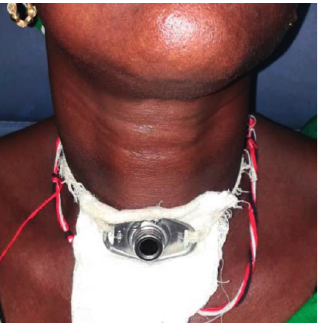
Figure 3: Tracheotomy cannula in a patient with recurrent la- ryngeal